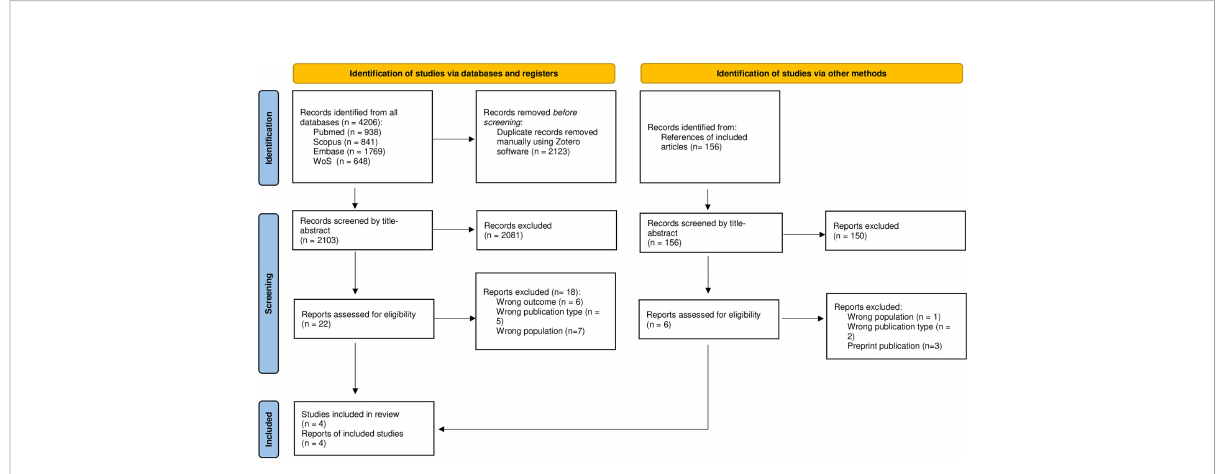
FIGURE 2 Flow diagram summarizing the process of literature search and